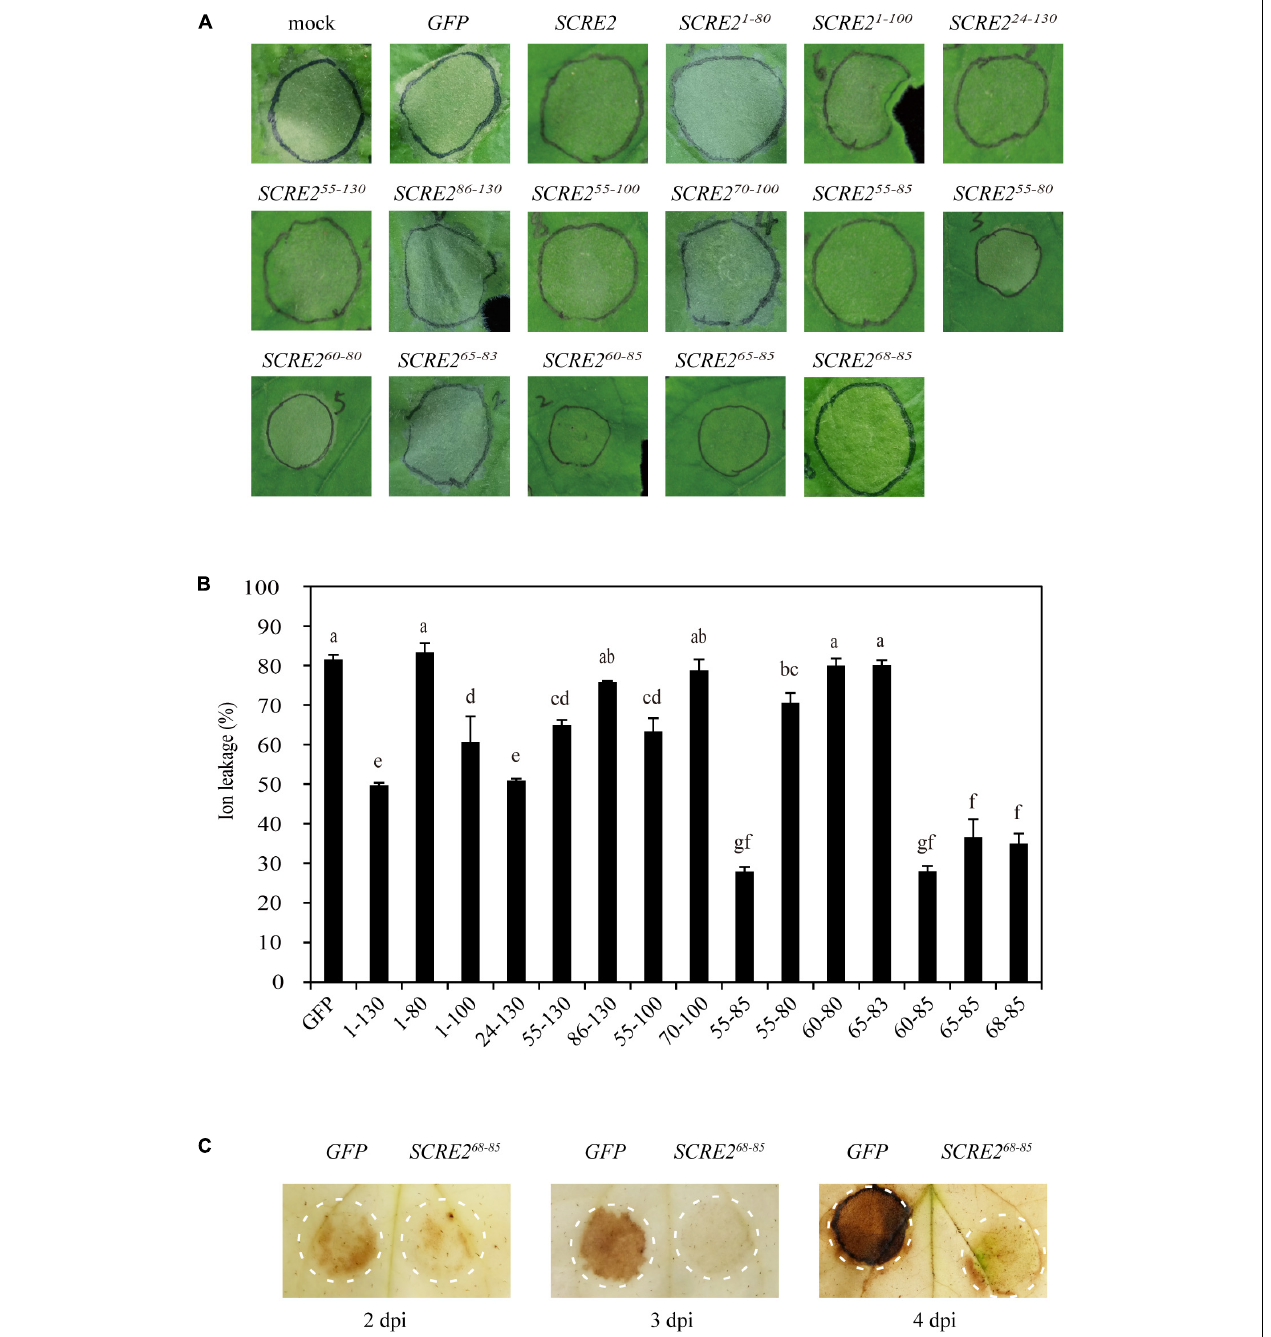
FIGURE 4 | SCRE2 68 - 85 is defined as a small peptide region to retain the immunosuppression ability in N. benthamiana . (A) cell-death symptoms on the infiltrated leaves at 4 days after co-infiltration with Agrobacterium strains carrying the BAX gene and different SCRE2 constructs expressing SCRE2, SCRE2 1 - 80 , SCRE2 1 - 100 , SCRE2 24 - 130 , SCRE2 55 - 130 , SCRE2 86 - 130 , SCRE2 55 - 100 , SCRE2 70 - 100 , SCRE2 55 - 85 , SCRE2 55 - 80 , SCRE2 60 - 80 , SCRE2 65 - 83 , SCRE2 60 - 85 , SCRE2 65 - 85 , and SCRE2 68 - 85 , respectively. (B) The severity of cell death was quantified by ion leakage in the infiltrated N. benthamiana leaves. Ion leakage from leaf discs co-infiltrated with Agrobacterium strains carrying the BAX gene and different truncated SCRE2 constructs was measured at 4 days post-infiltration (dpi). Co-expression of green fluorescent protein (GFP) was used as a negative control. Data are means ± standard error (SE) from three independent experiments. Different letters (a–g) indicate significant difference in ion leakage from leaf discs co-expressing BAX and different truncated SCRE2 proteins ( P < 0.05). (C) BAX-triggered reactive oxygen species (ROS) accumulation in the infiltrated N. benthamiana leaves was largely attenuated by co-expression with SCRE2 68 - 85 as compared with GFP co-expression. The Agrobacterium strain carrying GFP or SCRE2 68 - 85 construct was coinfiltrated into N. benthamiana leaves with Agrobacterial cells carrying the BAX gene construct, respectively. 3, 3 (cid:48) -diaminobenzidine (DAB) staining was performed at 2, 3, and 4 dpi. Circles represent the infiltrated areas in the leaves.